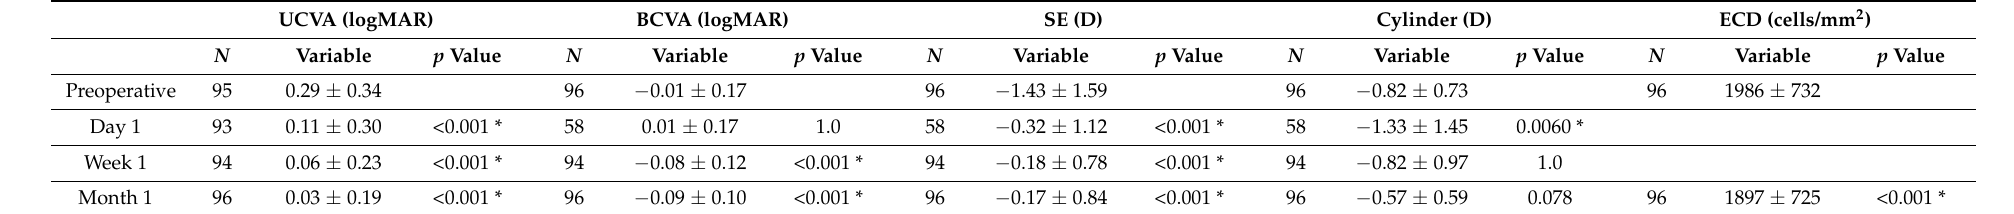
Table 2. Changes in each